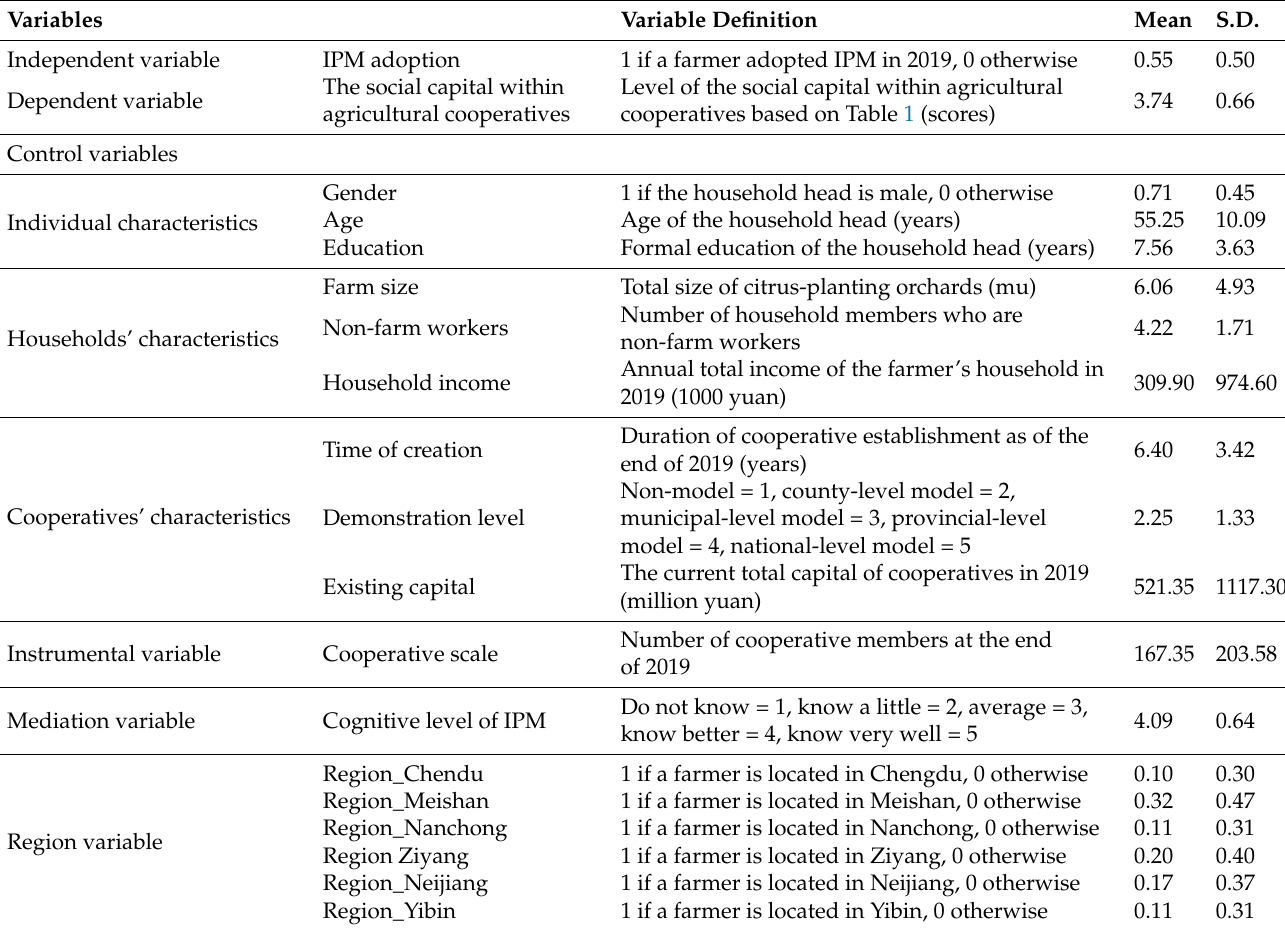
Table 2. Variable selection and description